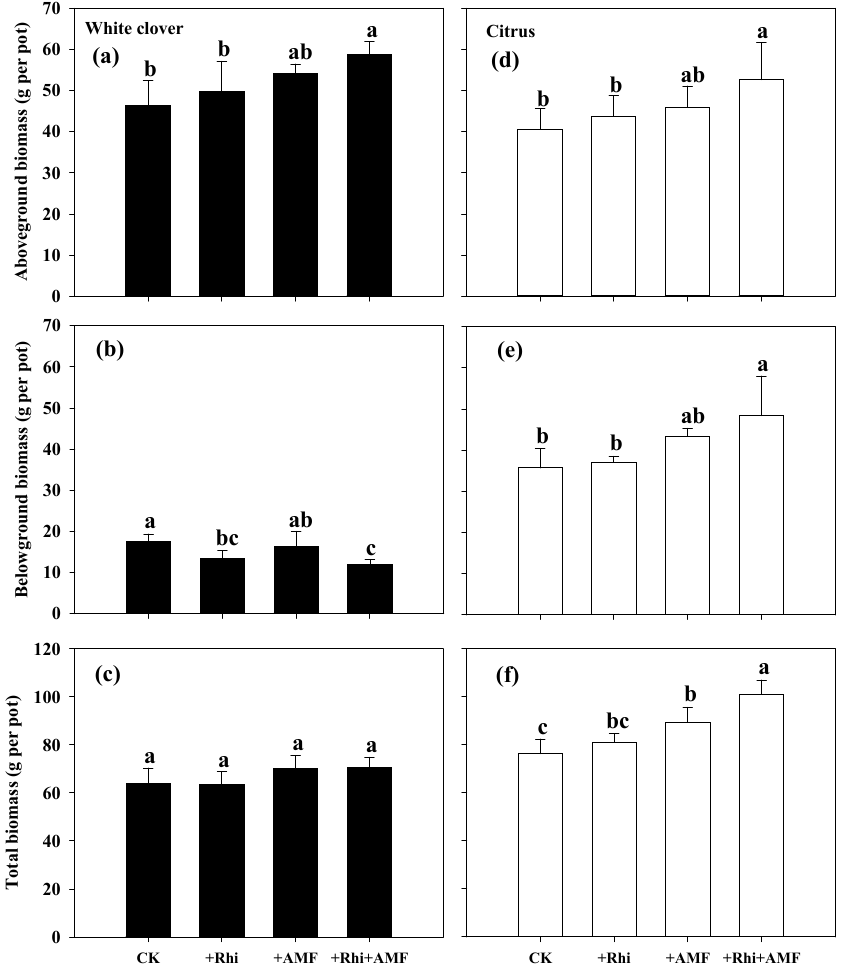
Figure 2. Aboveground ( a , d ), belowground ( b , e ), and total biomass ( c , f ) (g per pot) for white clover and citrus affected by rhizobia and mycorrhizal. Different letters above columns designate significant differences ( p < 0.05) between treatments. Abbreviations: CK, no rhizobium and no arbuscular mycorrhizal inoculation; +Rhi, inoculated with rhizobium; +AMF, inoculated with mycorrhizal fungus.